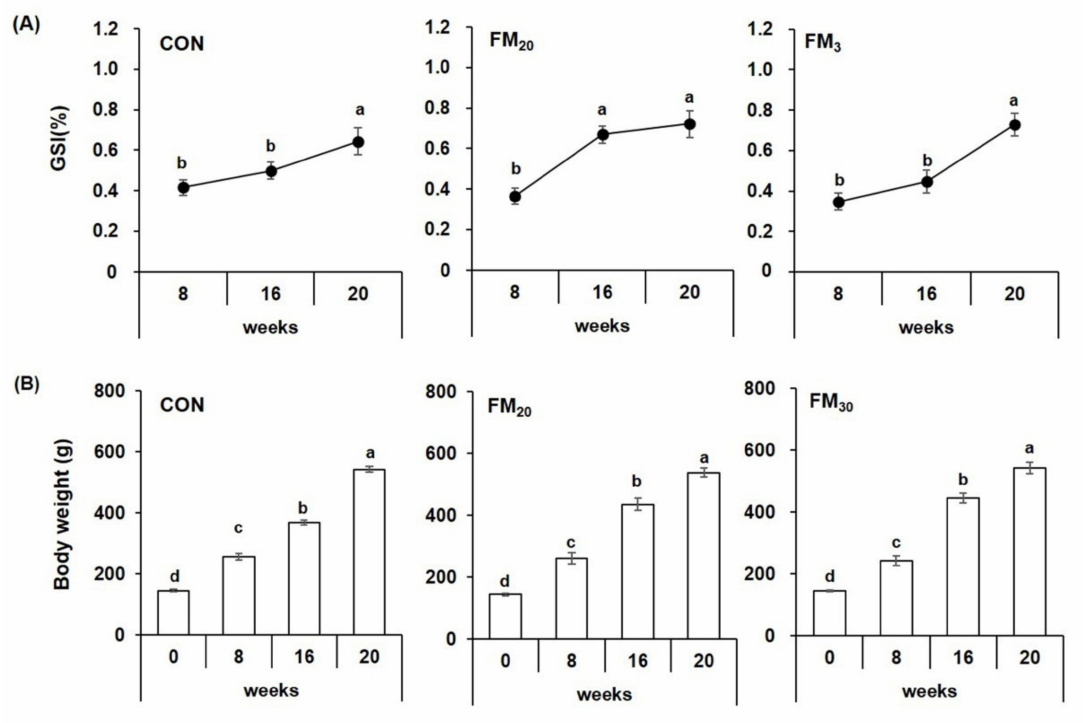
Figure 2. Gonadosomatic index (GS ( A )) and total body weight ( B ) of the olive flounder Paralichthys olivaceus. Data are presented as the mean ± SEM ( n = 20). Different letters above the bars indicate significant differences ( p < 0.05) between groups at each sampling time point. CON is the control basal diet in which no fishmeal was replaced, FM 20 is the diet with 20% of the fishmeal replaced, and FM 30 is the diet with 30% of the fishmeal replaced.